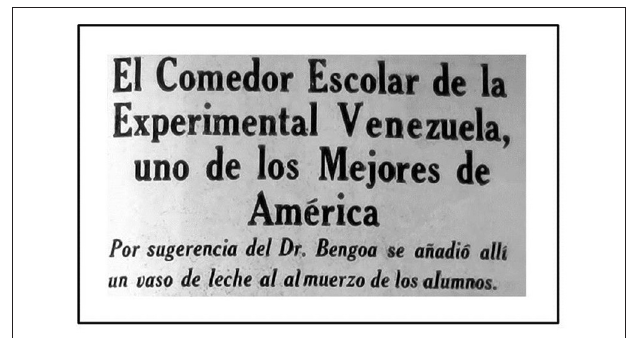
FIGURE 1 | A 1943 newspaper account of the opening of the first Venezuelan school diner. “The diner of the Experimental Venezuela School, one of the best in America. By suggestion of Dr. Bengoa a glass of milk was added to the students’ lunch.” Source: José María Bengoa personal